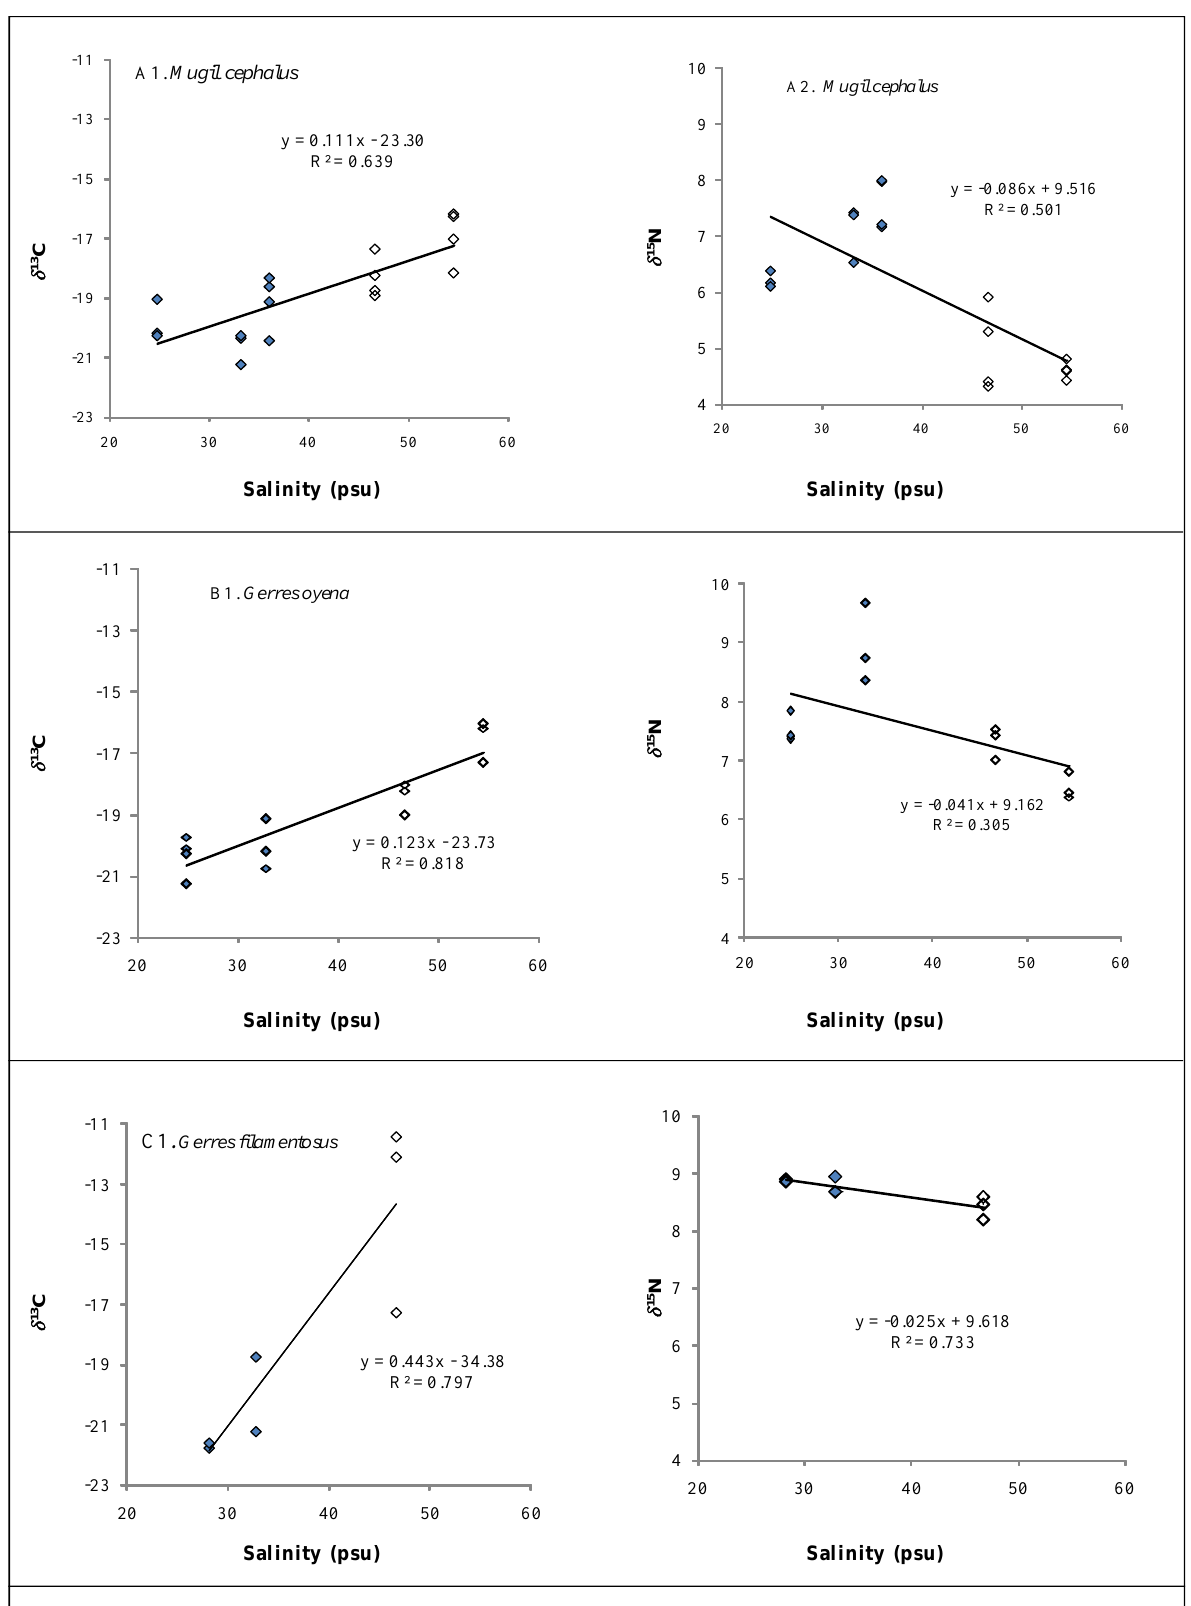
Figure 6: Relationships between  13 C and  15 N values and salinity in musle tissue of M. Cephalus (A), G. Ogena (B) and G. Fllamentos (C). Undisturbed sites (filled symbols) and disturbed sites (open